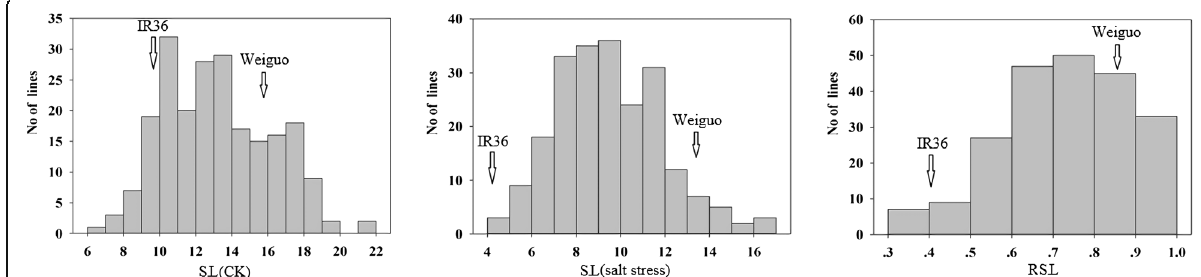
Fig. 6 Phenotypic distribution of SL under salt stress and CK and RSL of 199 F 2:3 lines. SL: Shoot length; RSL: Relative Shoot length; CK represents the lines growth in water at the bud burst stage. Arrows indicate the phenotypic value of IR36 and